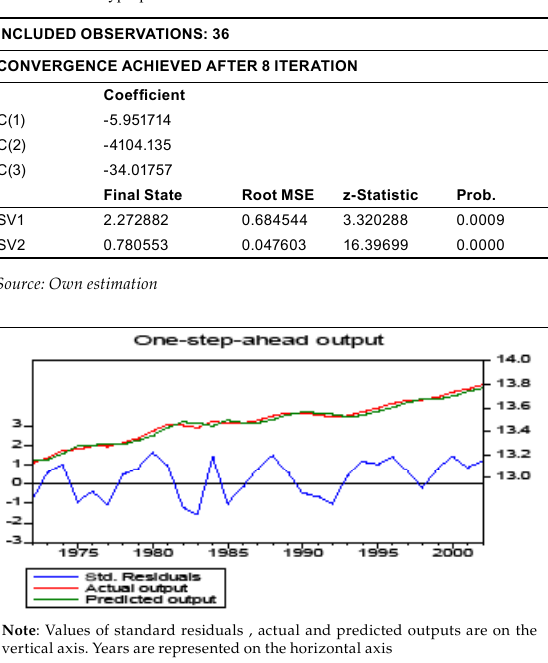
table 4 Hyperparameters and final values of the state vector